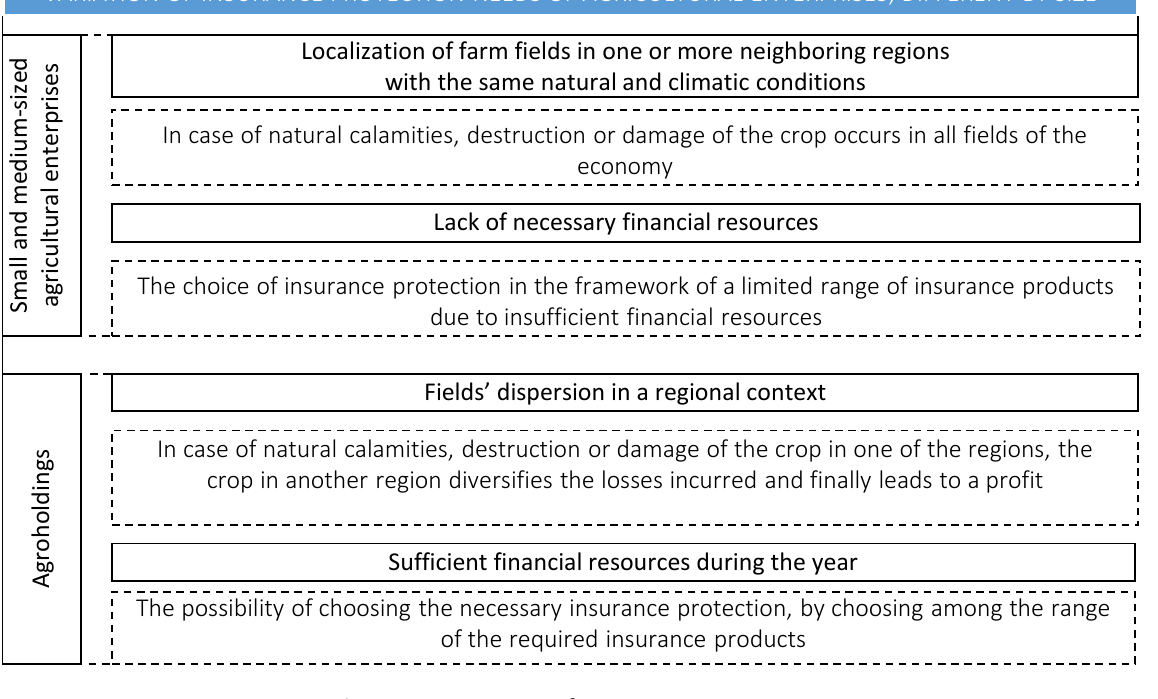
Figure 14. Features of insurance protection for different by size of agricultural